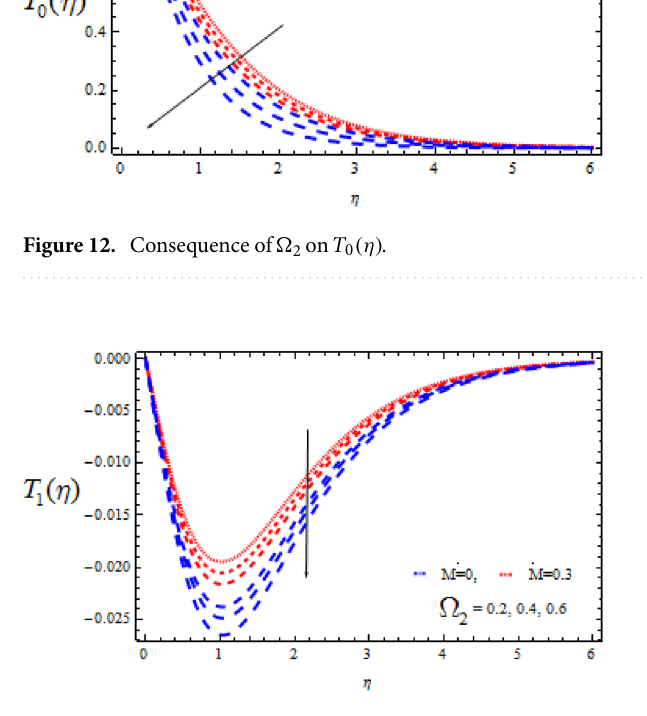
Figure 13. Consequence of (cid:31) 2 on T 1 (η)